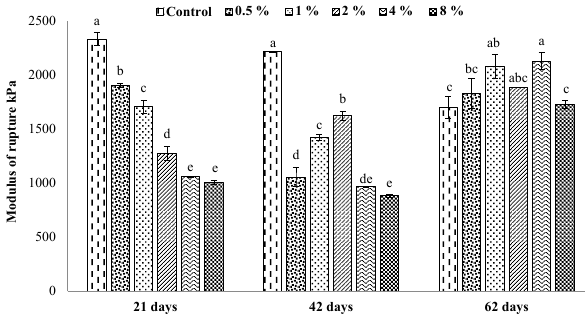
Figure 2. Effects of different rates of SMC application on aggregate stability (mean ± SD<0.05). Means followed by the same letter are not statistically different as determined by a least significant differ- ence test.